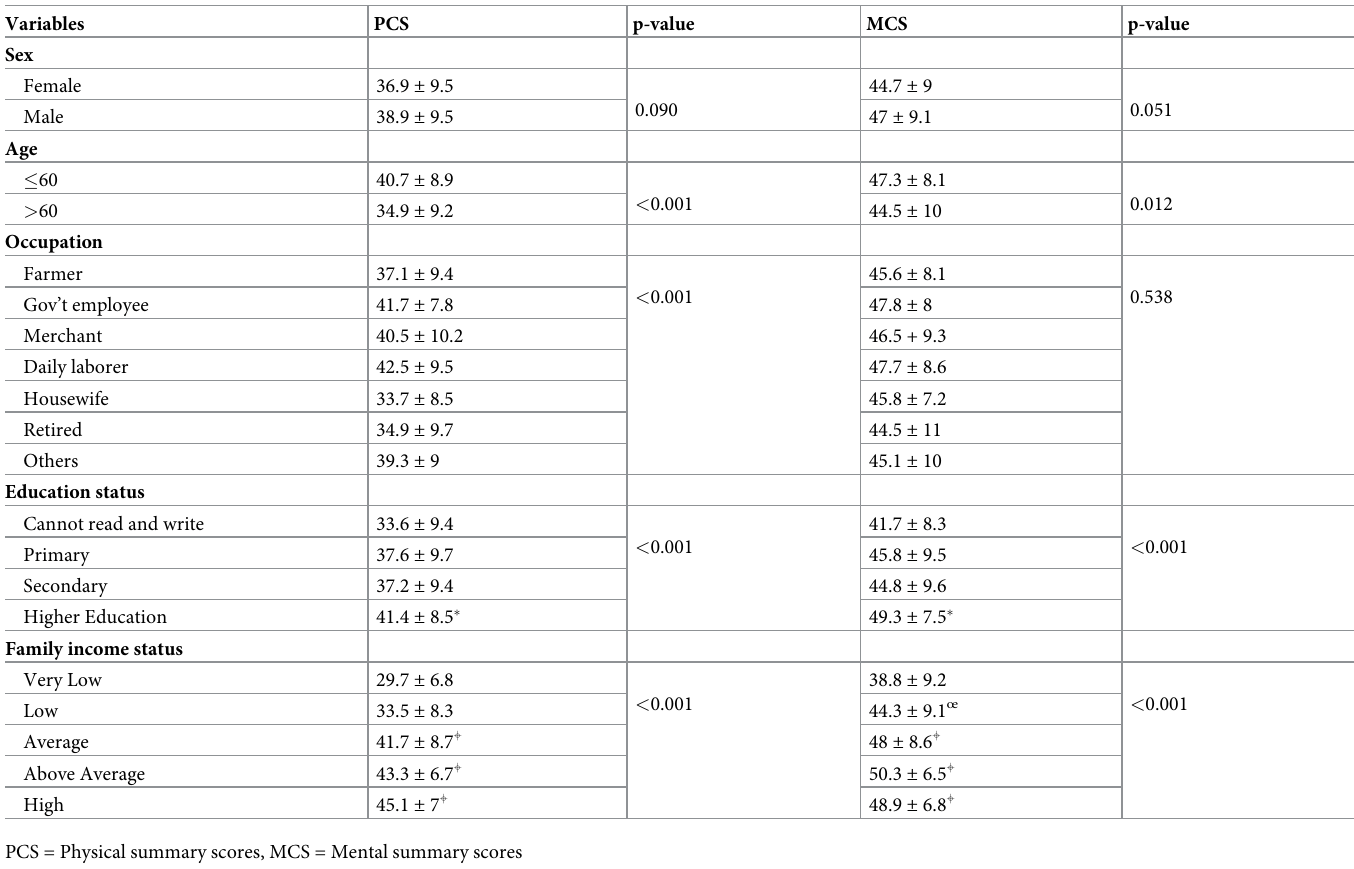
Table 6. Comparative statistical analysis of the mean scores of physical and mental composite summaries of patients with chronic kidney disease, according to the categorical socio-demographic